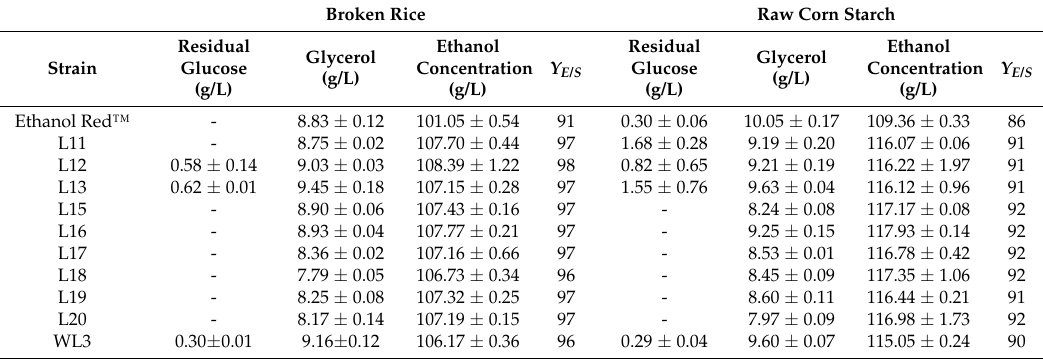
Table 2. Ethanol, glucose and glycerol content of SSF experiment at 30 ◦ C using as substrate broken rice or raw corn starch. The substrate loading for each experiment was 20% (w/v). The experiment was conducted in triplicate ( ± SD). Y E/S , % of theoretical maximum ethanol yield per gram of glucose equivalent available. Broken Rice Raw Corn Starch Ethanol Residual Ethanol Residual Glycerol Glycerol Y Y E/S Concentration Concentration Glucose Strain Glucose (g/L) (g/L) (g/L) (g/L) (g/L) (g/L)